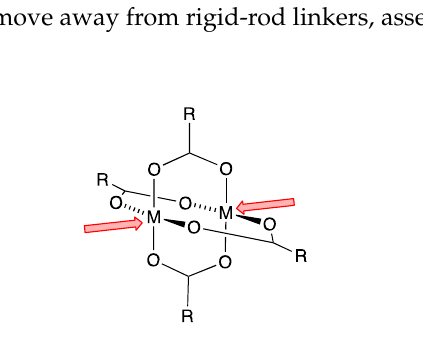
Scheme 1. Representation of an {M 2 ( μ -O 2 CR) 4 } paddle-wheel secondary building unit (SBU) with available coordination sites.